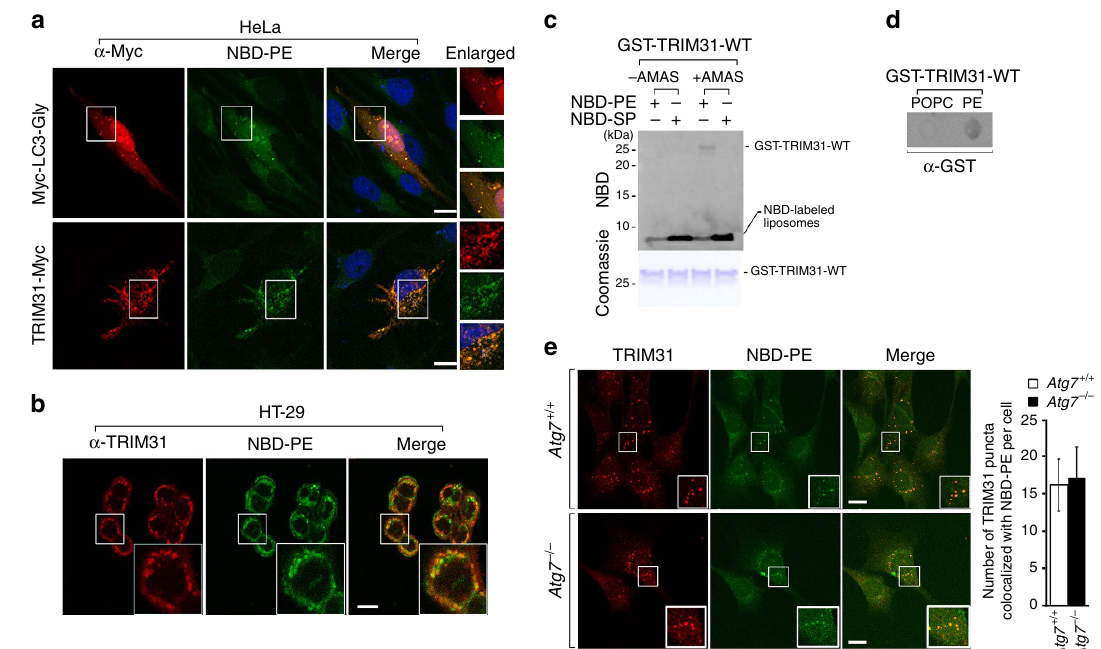
Figure 4 | TRIM31 interacts with PE in an Atg7-independent manner. ( a ) Colocalization of NBD–PE with TRIM31-Myc in HeLa cells. Intracellular NBD–PE labelling using delivery of liposomes consisting 80% 18:1–16:0 PC and 20% 18:1–12:0 NBD–PE. Cells were exposed to liposomes, washed with PBS, and maintained in complete media for 2h. The C-terminal glycine-exposed form of LC3, Myc-LC3-Gly, was used as a positive control. ( b ) Colocalization of NBD–PE with endogenous TRIM31 in HT-29 cells. Cells were exposed to NBD–PE liposomes and fixed. Cells were then immunostained with an anti-TRIM31 antibody. Scale bars, 5 m m. ( c ) Crosslinking experiment of purified GST-tagged TRIM31-wild-type B-Box (GST-TRIM31-WT) with liposomes consisting of 20% NBD–PE/80% POPC or 20% NBD-sphingosine/80% POPC. Liposomes were incubated with the cross-linker AMAS (0.5mM), and then glycine was added to terminate the crosslinking reaction. GST-TRIM31-WTwas added to the reaction buffer, and sample reactions were terminated with the addition of 5 (cid:3) SDS loading buffer. The LAS image analyser was used to detect NBD fluorescence (upper) while Coomassie blue staining was used to visualize protein levels (bottom). ( d ) The ability of the GST-tagged TRIM31-wild-type B-Box (2 m gml (cid:2) 1 ) to bind PE or POPC was analysed by a protein-lipid binding assay on nitrocellulose. Nitrocellulose membranes were spotted with 100pmol of phospholipid. ( e ) TRIM31-Myc colocalizes with NBD–PE in puncta independent of Atg7. Wild-type or Atg7 (cid:2) / (cid:2) cells stably expressing TRIM31-Myc were labelled with liposomes containing 20% NBD–PE and 80% PC and chased in complete media for 1h, followed by immunostaining with anti-Myc antibody. Scale bars, 5 m m. Quantification is shown in the right graph (mean ± s.d.). All data are representative of at least three independent